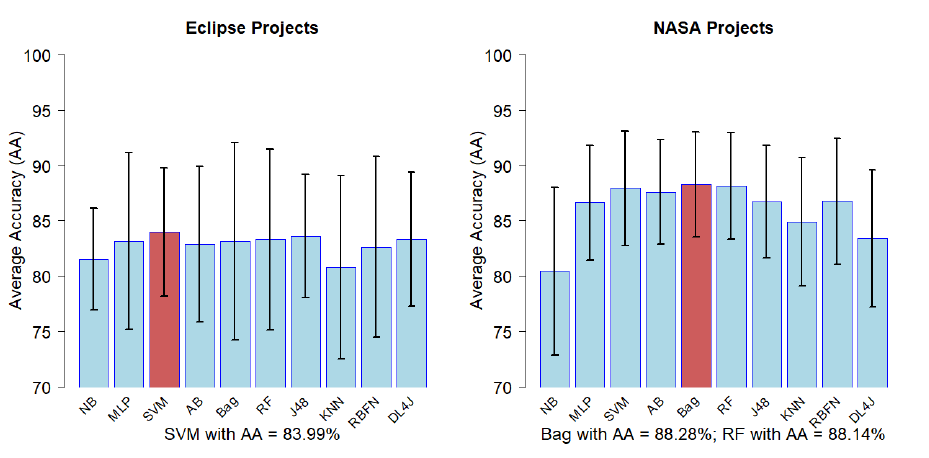
Figure 2. Solution Workflow